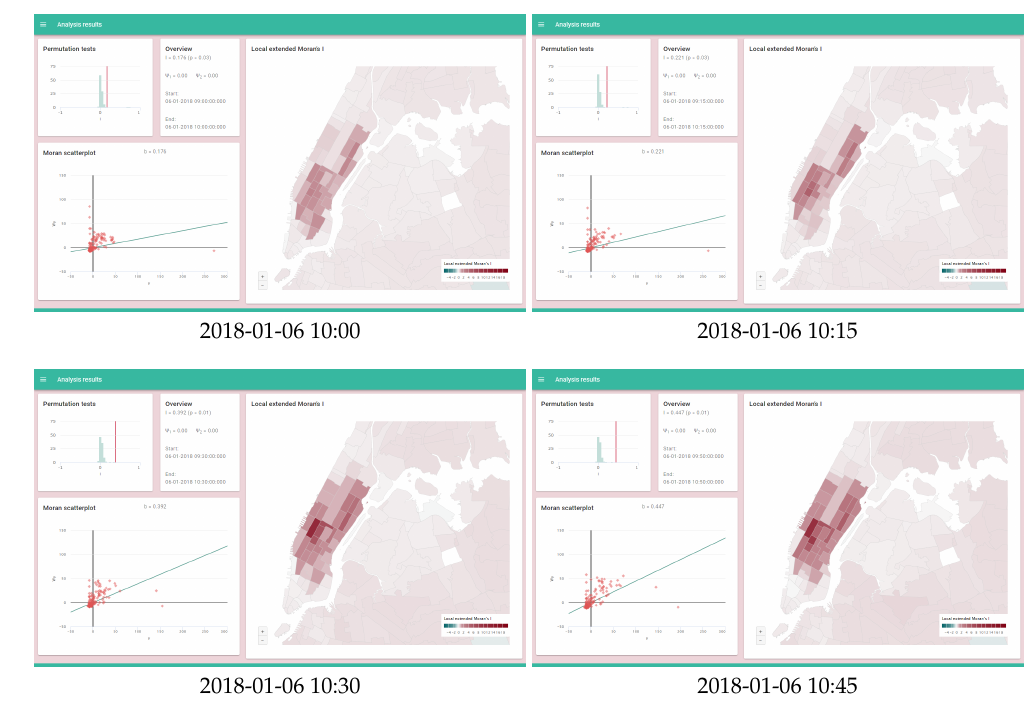
Figure 6. Comparison of four result sets in the result